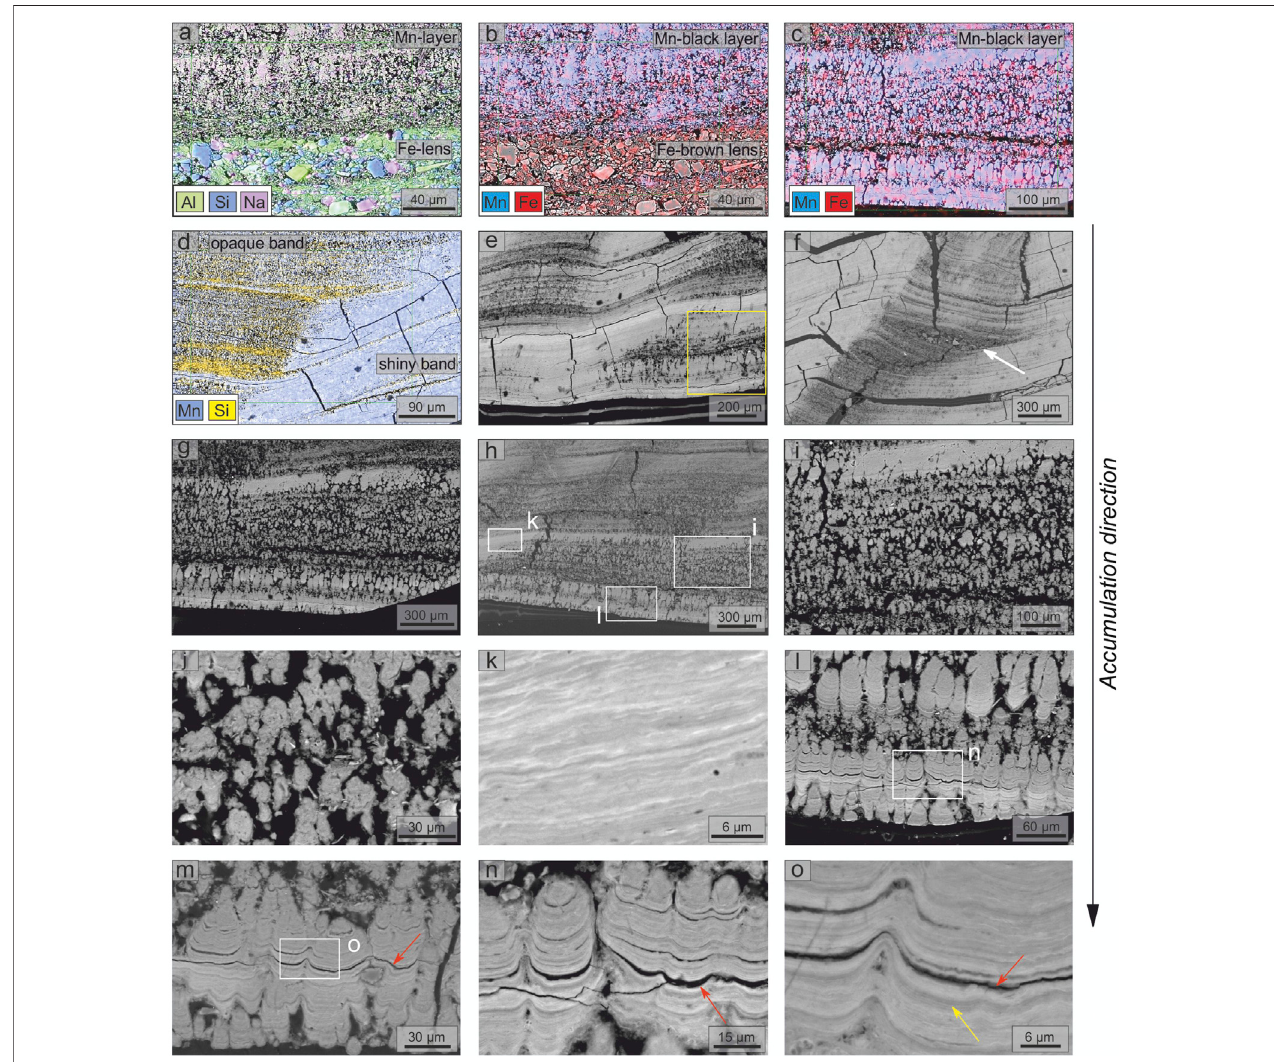
FIGURE 4 | SEM-EDS investigation of polished cross-section of the Fe-Mn patinas (sample GC): (A, B) EDS elemental maps (Mn, Fe, Al, Si, and Na) of the boundary betweenbrownFe-lensand black Mn-layer; (C, D) EDS elemental maps (Mn,Fe, and Si) ofblack Mn-layers; (E, F) alternationoftheshiny and opaque bands, yellow box indicates the position of Raman map shown in Figure 7 ; (G, H) spatial distribution of the three different morphotypes identi fi ed, white boxes indicate the positions of panels (I) , (K) , and (L) ; (I, J) detail of the branched columnar morphotype; (K) detail of the fl at-laminated morphotype; (L – O) details of the columnar or pseudo-columnar morphotype (see Figure 2 for the position on the sample). White arrow indicates a lens of debris. Red arrows indicate discontinuity between laminations. Yellow arrow shows ∼ 1.5 μ m bands.